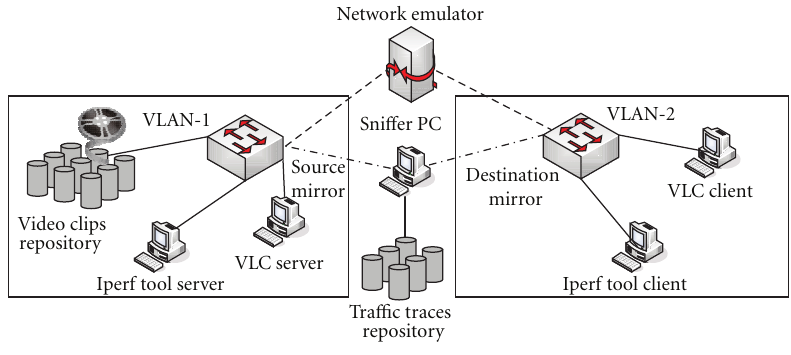
Figure 3: IPTV testbed setup.